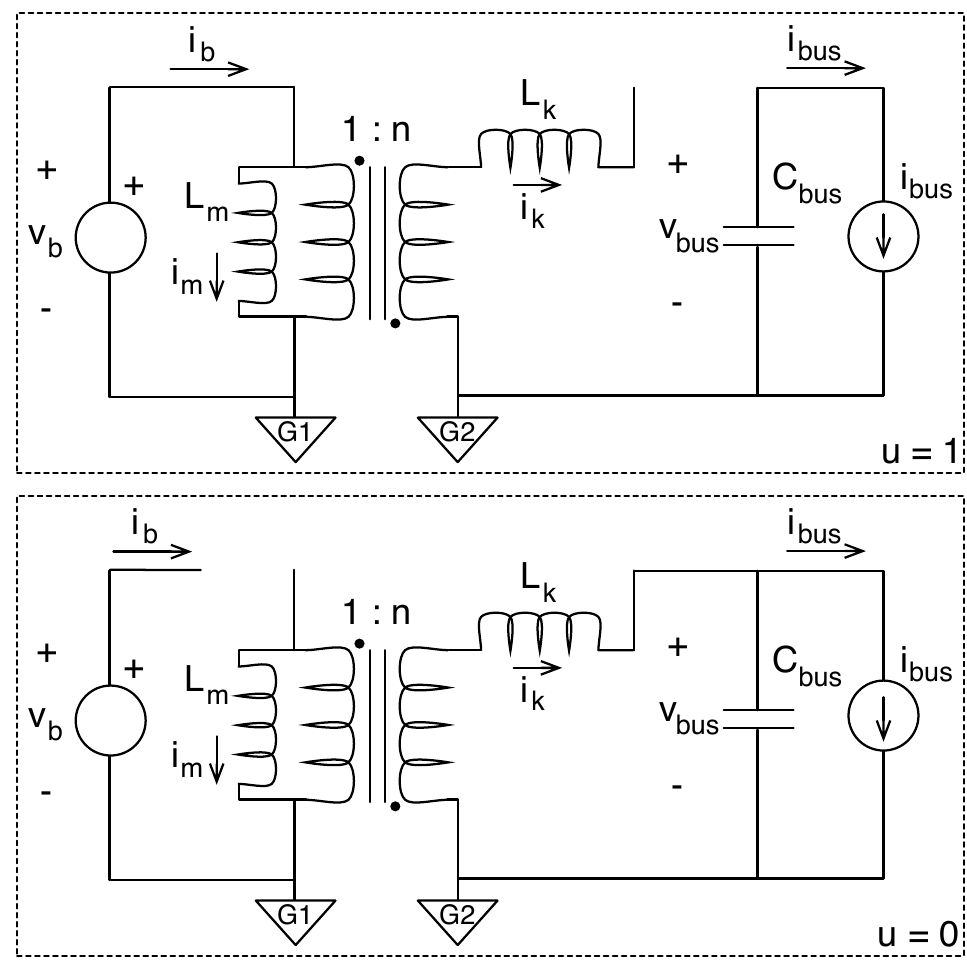
Figure 2. Circuital topologies of the battery